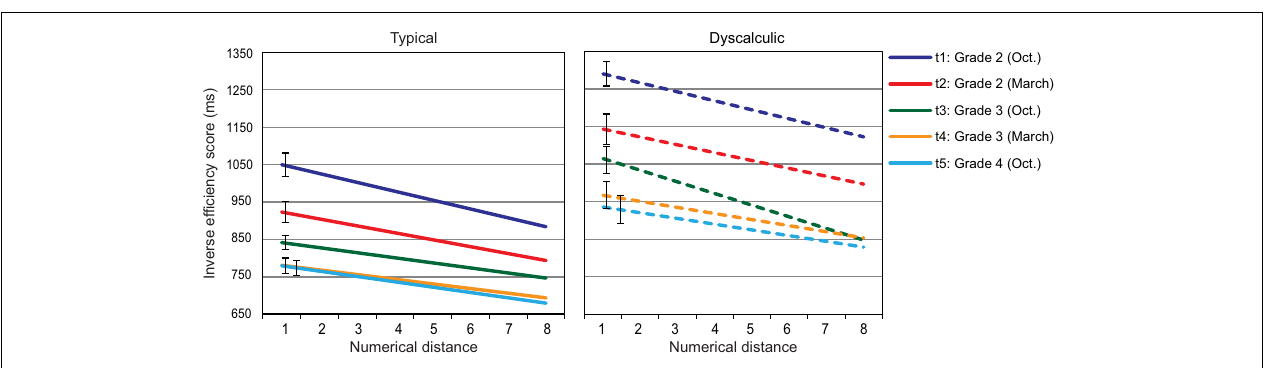
FIGURE 4 | Single digit comparison: regression lines of IE-scores in relation to numerical distance across five assessment points (error bars represent SEs of intercepts).